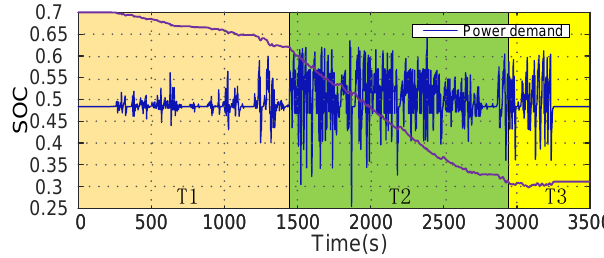
Figure 18. SOC trajectory of real-world driving cycle